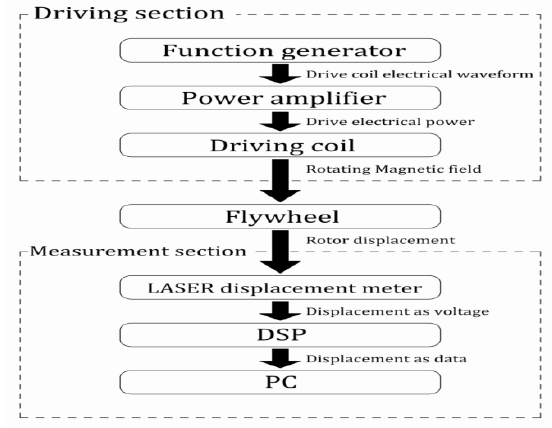
Figure 12. Scheme of experimental equipment.